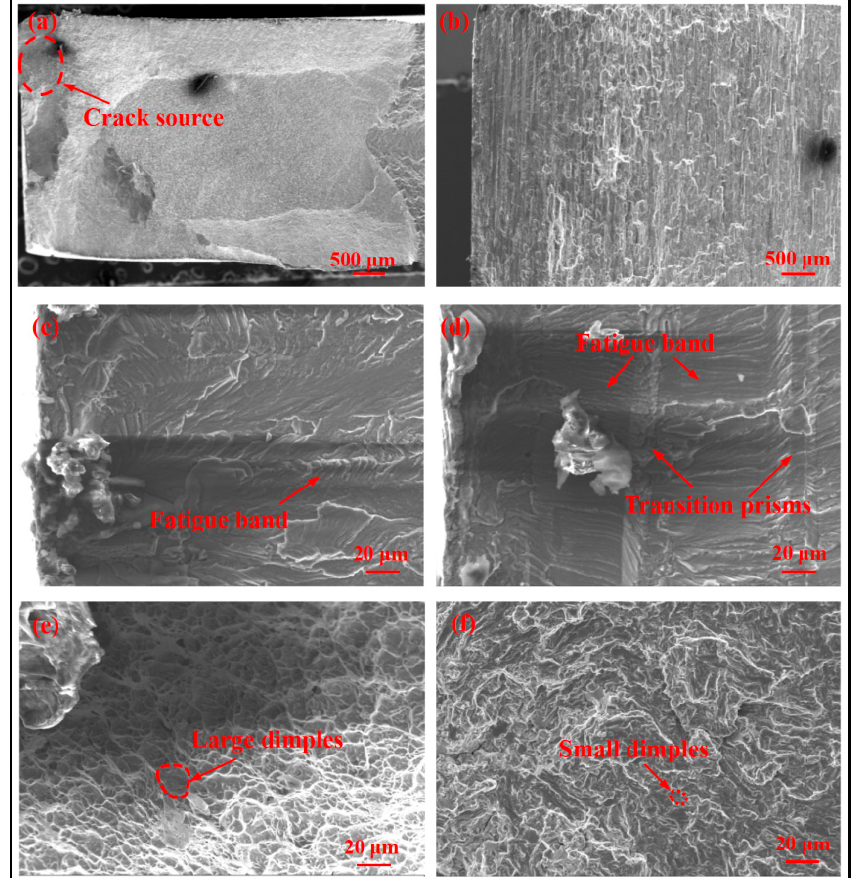
Figure 9. Morphology of the 7B04 aluminum alloy sample after the fatigue test. ( a ) Without a laser shock-peening sample; ( b ) a laser shock-peening sample; ( c ) a local enlarged figure of the crack initiation region without LSP; ( d ) a local enlarged figure of the crack initiation region with LSP; ( e ) a local enlarged figure of the final fracture without LSP; ( f ) a local enlarged figure of the final fracture region with LSP.